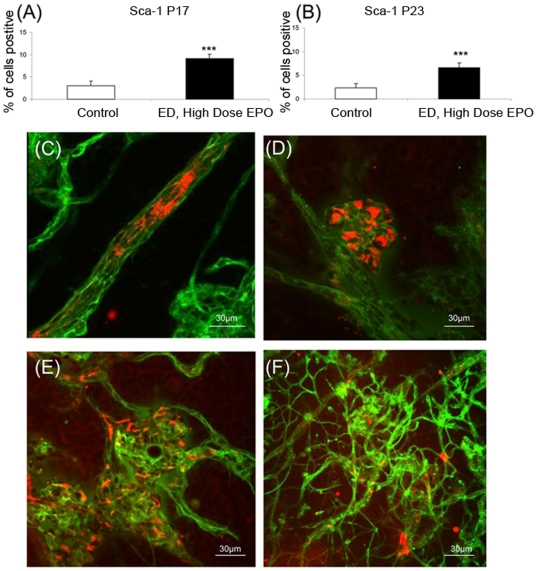
Epoetin delta stimulates haematopoetic stem cells in bone marrow and infiltration into the retinal vasculature.Sca-1 is a marker for haematopoetic stem cells (HSCs) and this was significantly enhanced in the marrow of mice treated with epoetin delta, both at P17 (A) and also P23 (B). (n = 5/group) ***p<0.001 (Error bars  =  Standard Error of the Mean). Sca-1 immunoreactivity in retinal flat-mounts demonstrated that this HSC marker was present in cells localised to intra (C) and pre-retinal blood vessels (D). Assessment of the retinal vasculature penetrating the ischaemia retina at P23 demonstrated that these vessels contained many Sca-1 positive cells (E). As with P17, these cells were also in clusters of pre-retinal neovessels at P23 (F).